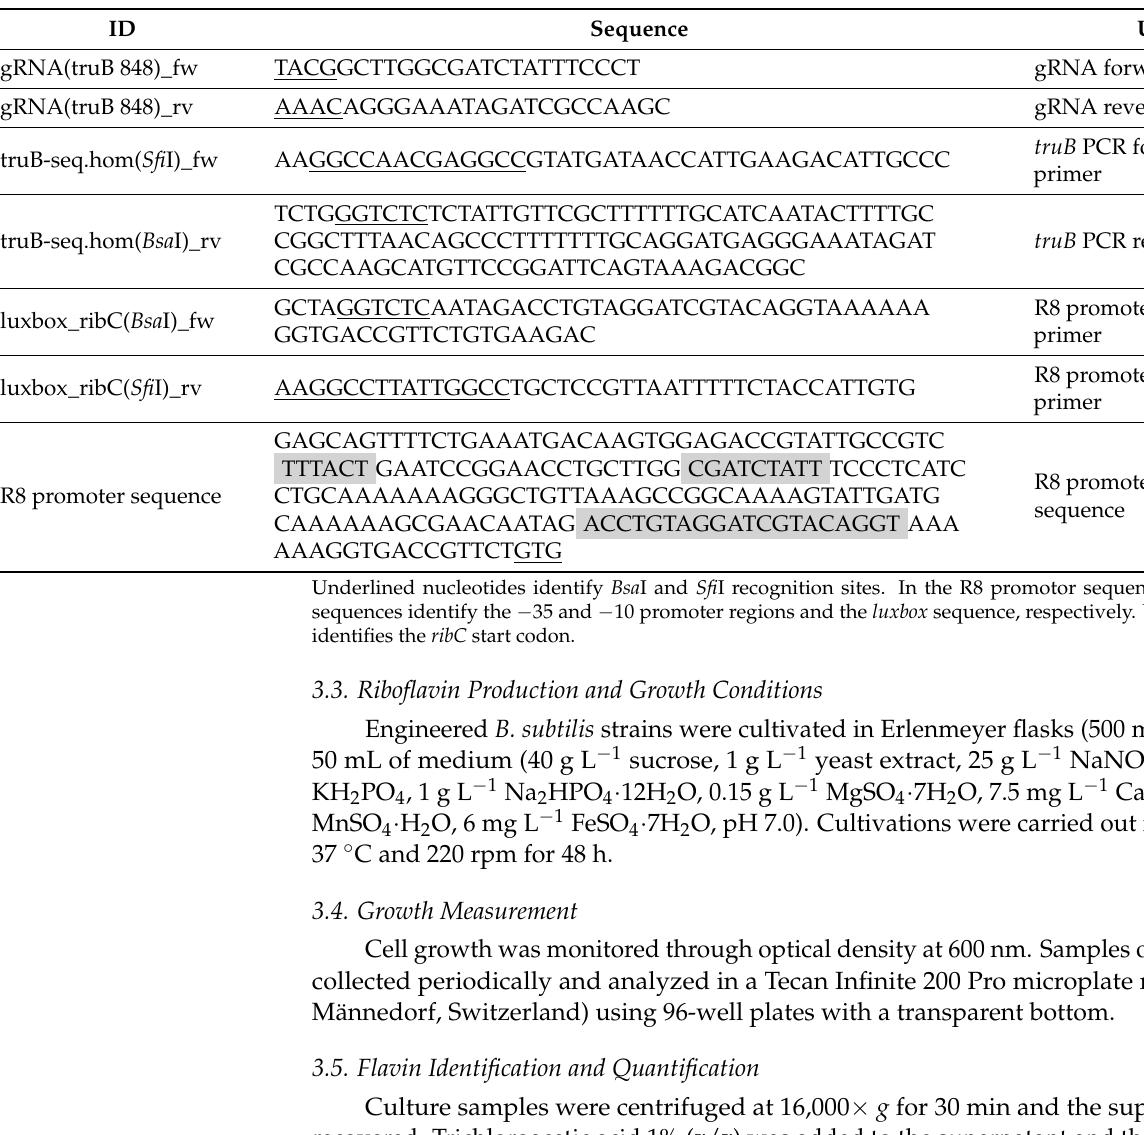
Table 1. DNA sequences used in this